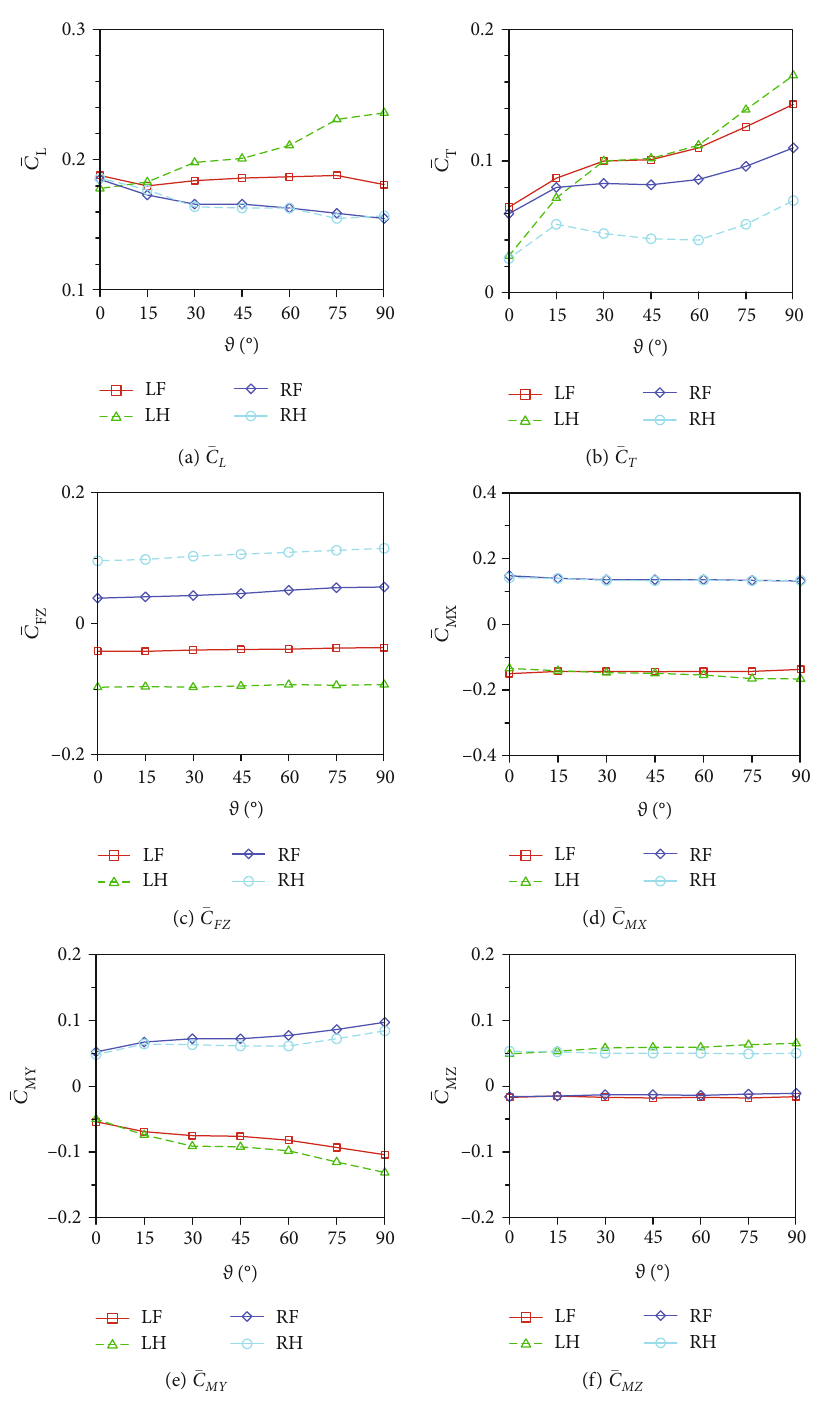
Figure 5: Coe ffi cients of single time-average aerodynamic force and moment vs ϑ